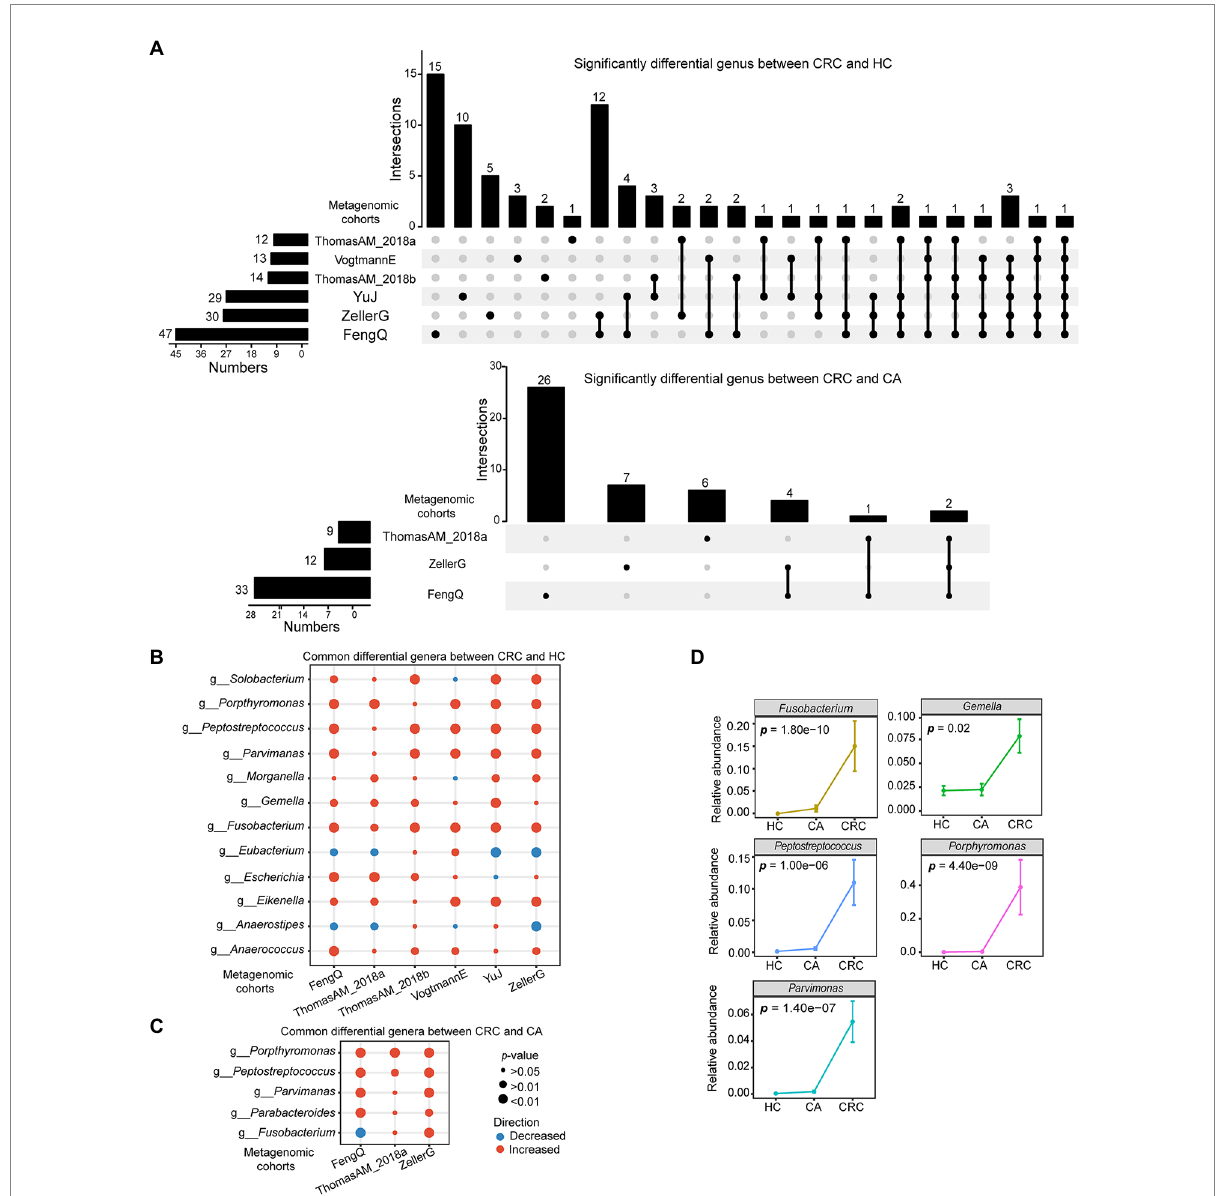
FIGURE 3 Significantly differential microbes at genus level in six metagenomic sequencing datasets. (A) UpSet plot showed significantly differential genus between CRC and HC or CA. (B,C) Bubble plot showed universal differential genus between CRC and HC or CA. (D) Five genera that abundances were significantly increased with disease progressed at FengQ cohort. p -value was calculated by Wilcoxon rank-sum